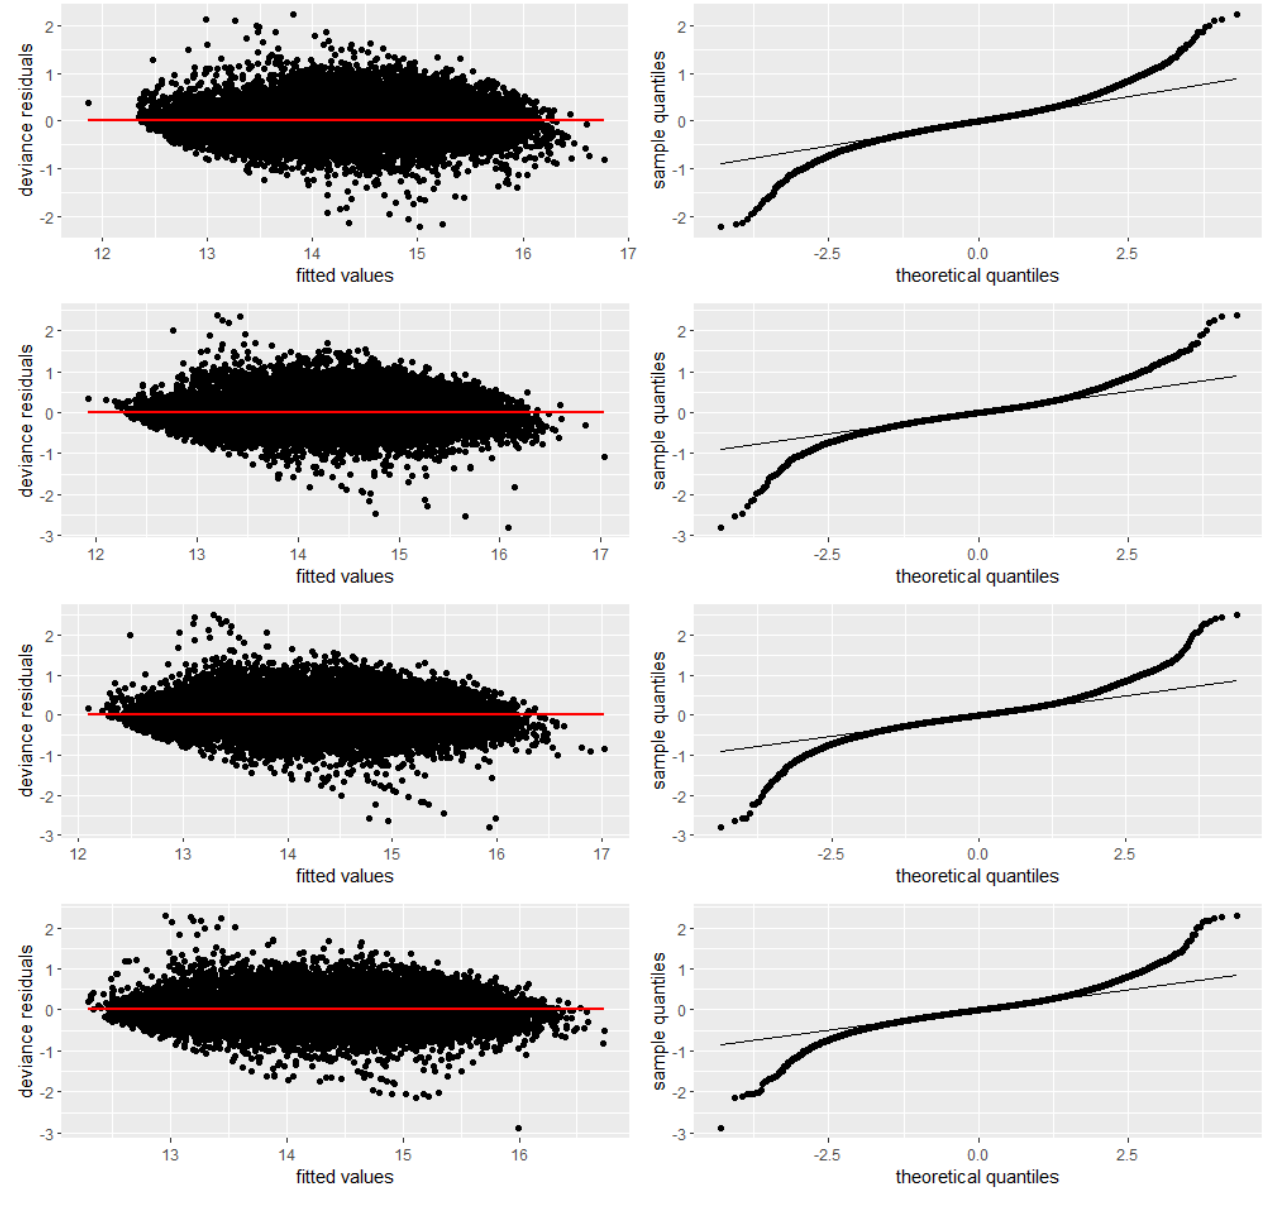
Figure 1: Log Linear Goodness of Fit